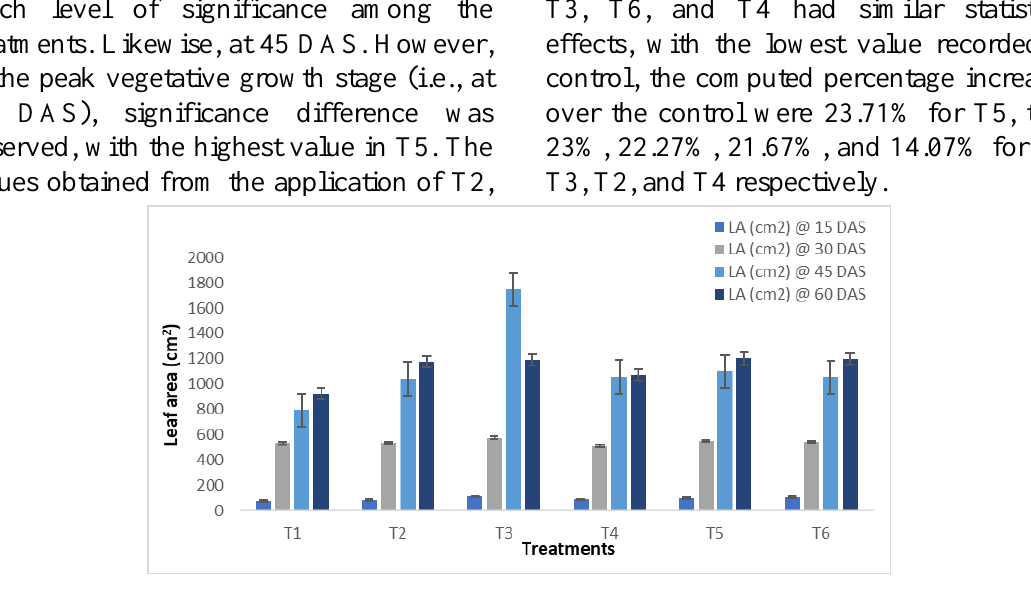
Figure 4. Effects of NPK consortia biofertilizer and chemical fertilizers on mean of total leaf area at different growth stages; LA = Leaf Area, DAS = Days after sowing